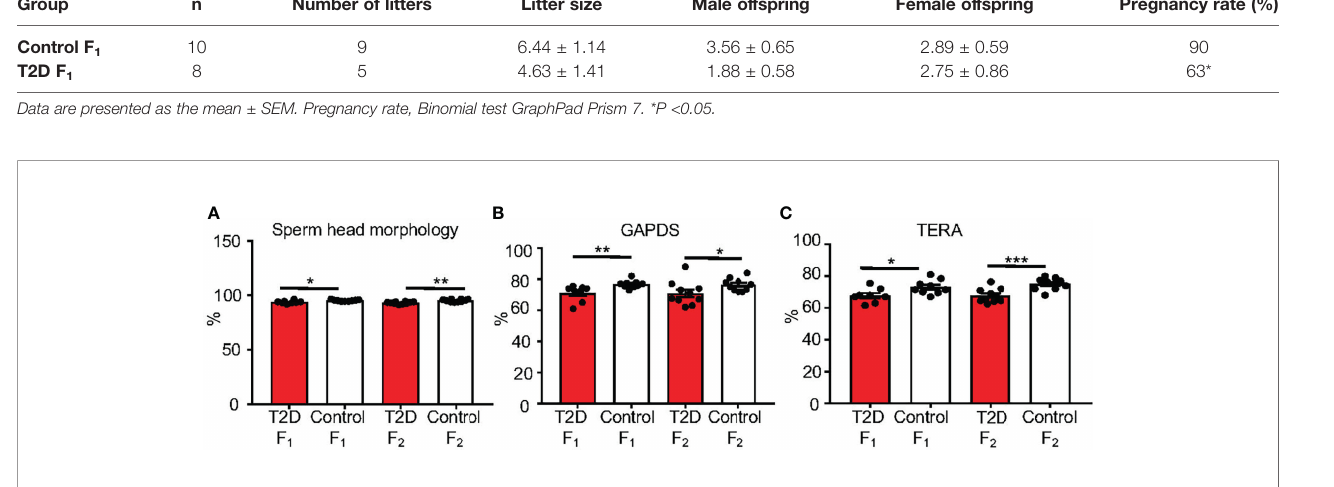
FIGURE 8 | Changes in sperm characteristics of the F 1 and F 2 offspring. (A) Evaluations of sperm head abnormalities of caudal epididymal sperm from the offspring F 1 and F 2 generations from T2D and control fathers. (B) The protein levels of glyceraldehyde 3-phosphate dehydrogenase-S (GAPDS) and (C) transitional endoplasmatic reticulum ATPase (TERA), as detected by immunolabeling of caudal epidymal sperm from the F 1 and F 2 offspring. All analyses were done at 10 weeks of age. Data are presented as the mean ± SEM. (n = 10 for all groups except n = 9 for T2D F 1 males/200 cells per each animal). Differences between groups were tested by t -test (GraphPad Prism 7.0). *P < 0.05, **P < 0.01, ***P <